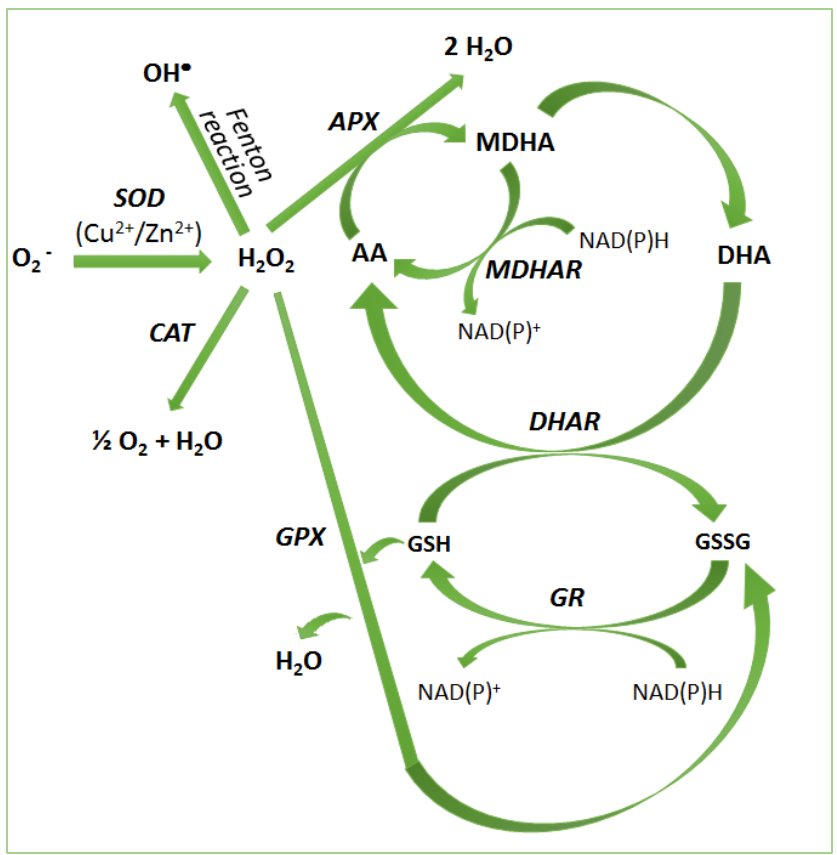
Figure 2. Enzymatic antioxidant systems to control redox homeostasis. Superoxide dismutase (SOD), catalase (CAT), ascorbate peroxidase (APX), glutathione peroxidases (GPX), monodehydroascorbate reductase (MDHAR), dehydroascorbate reductase (DHAR), glutathione reductase (GR), ascorbate (AA), monodehydroascorbate (MDHA), dehydroascorbate (DHA), oxidized glutathione (GSH), reduced glutathione (GSSG).